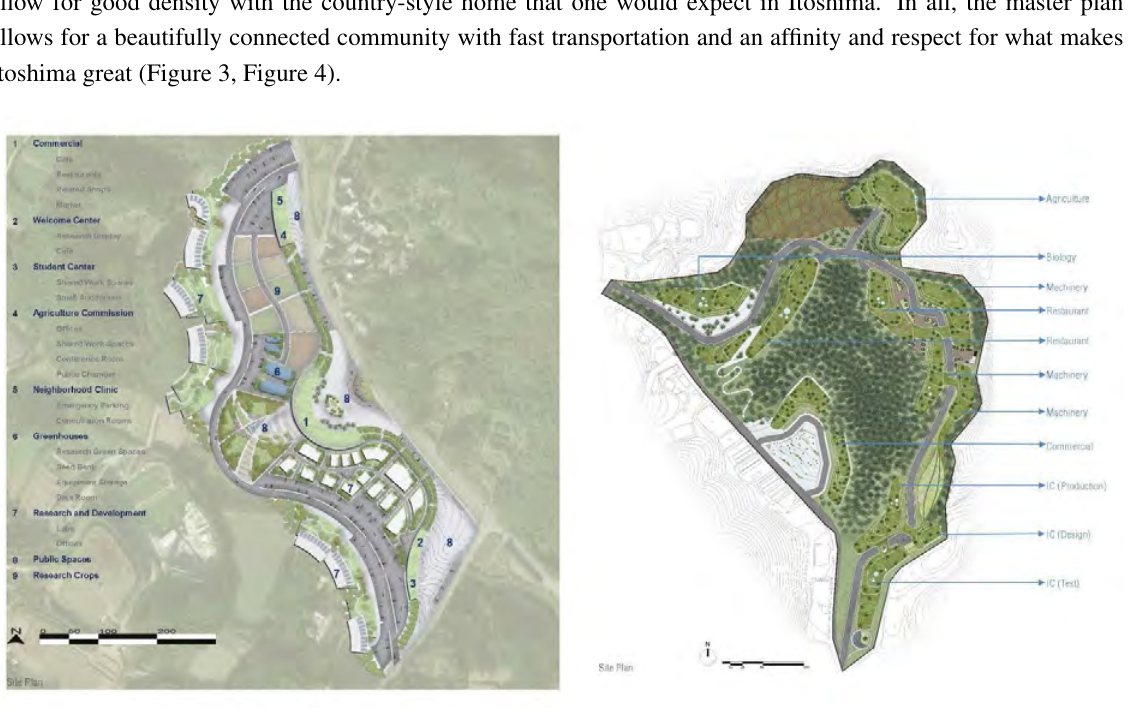
Figure 3. Student’s Proposal